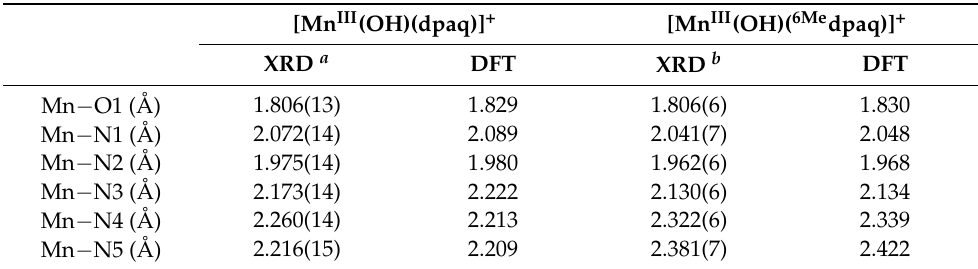
Figure 2. The electronic absorption spectrum of 1.0 mM [Mn III (OH)( 6Me dpaq)] + (blue trace) and 1.0 mM [Mn III (OH)(dpaq)] + in MeCN at 25 ◦ C shown for comparison (red trace). Table 1. Selected Manganese − Ligand Bond Lengths (Å) for [Mn III (OH)(dpaq)] + and [Mn III (OH)( 6Me dpaq)] + from X-ray Crystallography and DFT